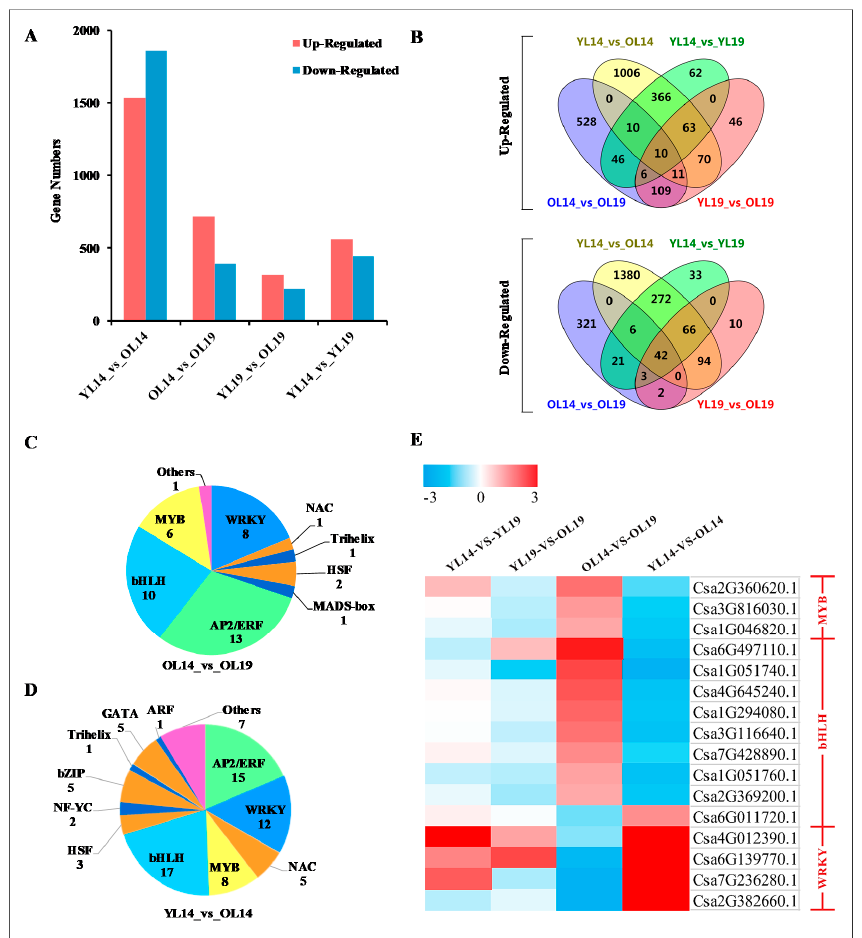
Figure 4. The statistics of the number of differentially expressed genes and cluster analysis of transcription factors. ( A ) Statistics of the number of upregulated and downregulated DEG in the four groups of samples. The Abscissa represents the comparison between samples (groups), and the ordinate indicates the significant differentially expressed genes de- tected. ( B ) The Venn diagram depicts the common and unique number of DEG among the four groups of samples. The quantitative distribution of differentially expressed TFs in OL14_vs_OL19 ( C ) and YL14_vs_OL14 ( D ). ( E ) The heat map shows the expression multiple changes (Log2 multiple changes) of the gene encoding transcription factor among four groups of samples.